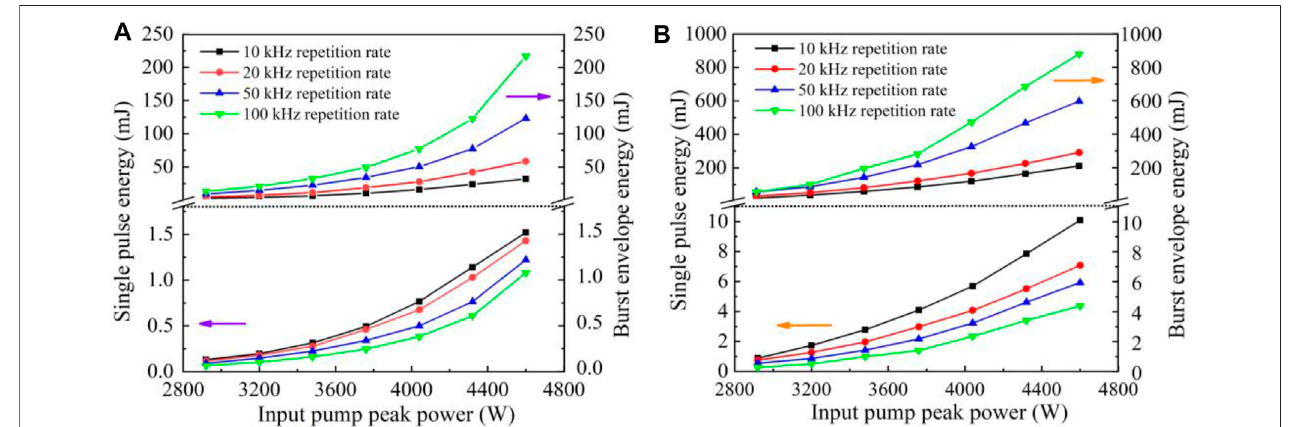
FIGURE 9 | Output burst energy and single-pulse energy versus input pump peak power at different repetition rates during double-pass ampli fi cation. (A) At the input single-pulse energy of 8.6 nJ. (B) For the input single-pulse energy of 116.51 nJ.